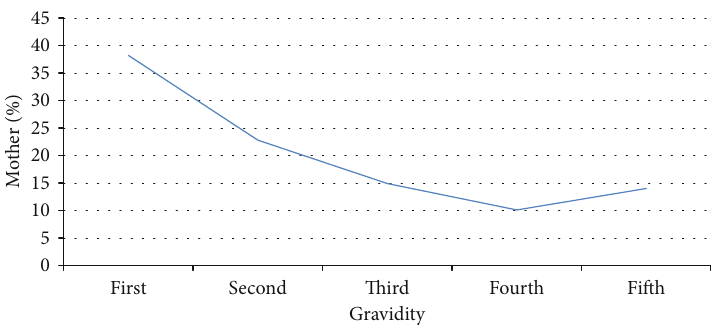
Figure 4: Line graph showing the percentage of mothers against their gravidity. Table 2: Gestational hyperglycaemia by maternal age and parity of study participants, N = 307